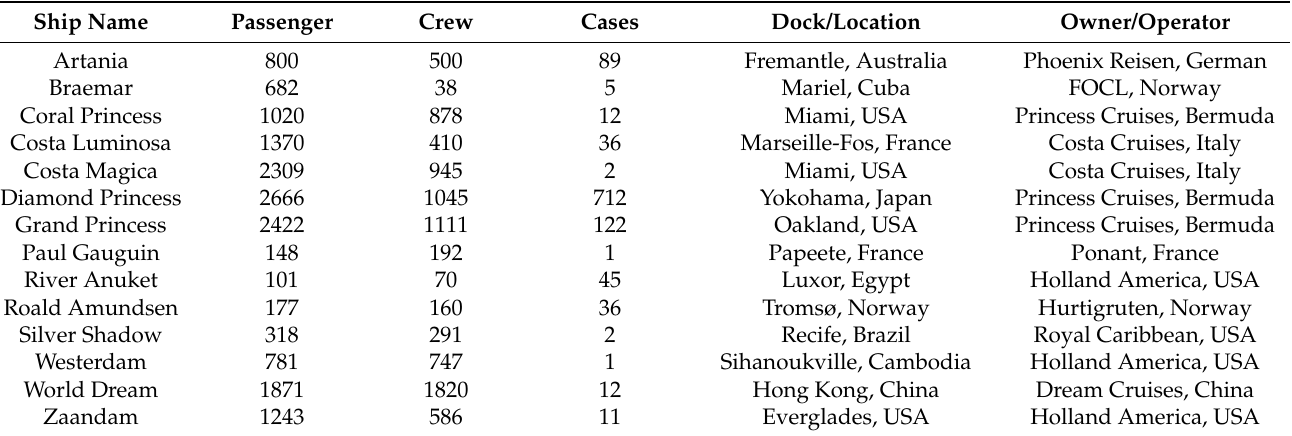
Table 1. List of selected COVID-19 cases on cruise